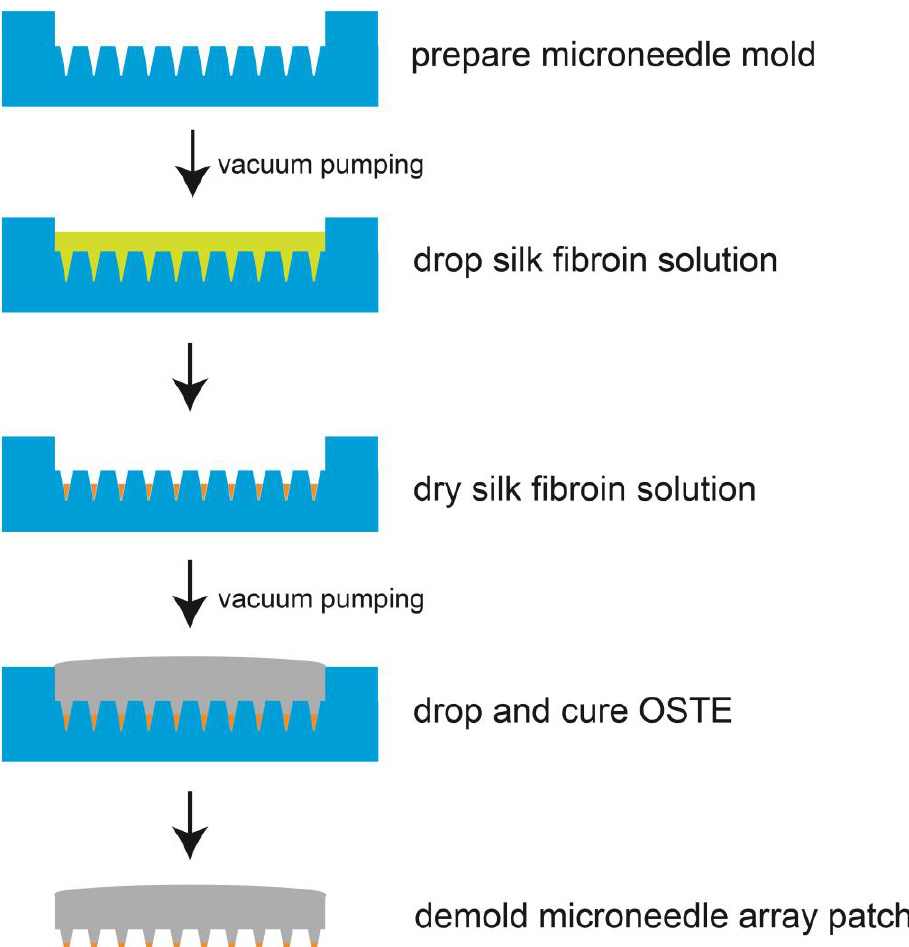
Figure 1. The schematic of the fabrication of microneedle array patches. At first, we prepare the mold, then we drop silk fibroin solution on the mold and make the silk fibroin solution fills the mold. After the silk fibroin solution is fully dry on the mold, we drop OSTE onto it and cure the OSTE. Lastly, we demold the OSTE microneedle array patch from the mold.